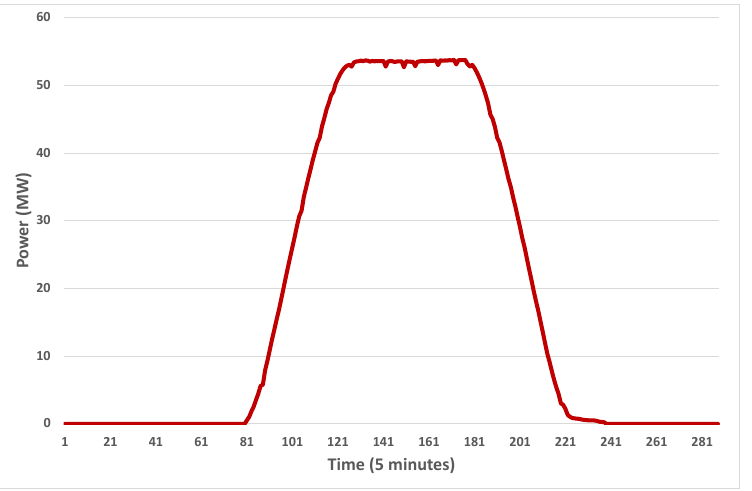
Figure 1. Clear day output in Broken Hill. Time is in 5 min intervals, with 288 intervals per day. Note that the figure shows the profile for a clear day in summer. In winter on a clear day, the output will still reach the peak, but the time at the peak will be shorter on average, due to the sun being lower in the sky. So, as with clear sky model estimation for irradiance, we have to cater for seasonal variation if we are to define an empirical clear sky output (CSO) model for solar farms. Thus, the method we choose is to calculate the maximum value of the output for each time step of the day for the last thirty days. Then, we smooth these values using exponential smoothing. It could also be performed using a moving average. An illustration of this method is shown in Figure 2.